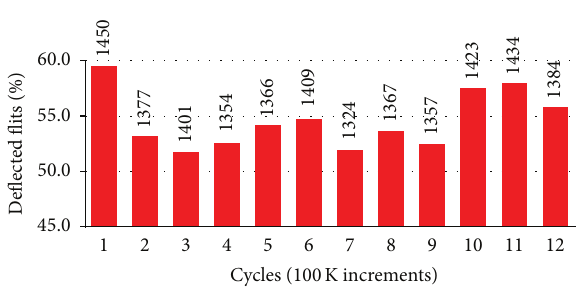
Figure 2: Percentage of deflected flits of mcf